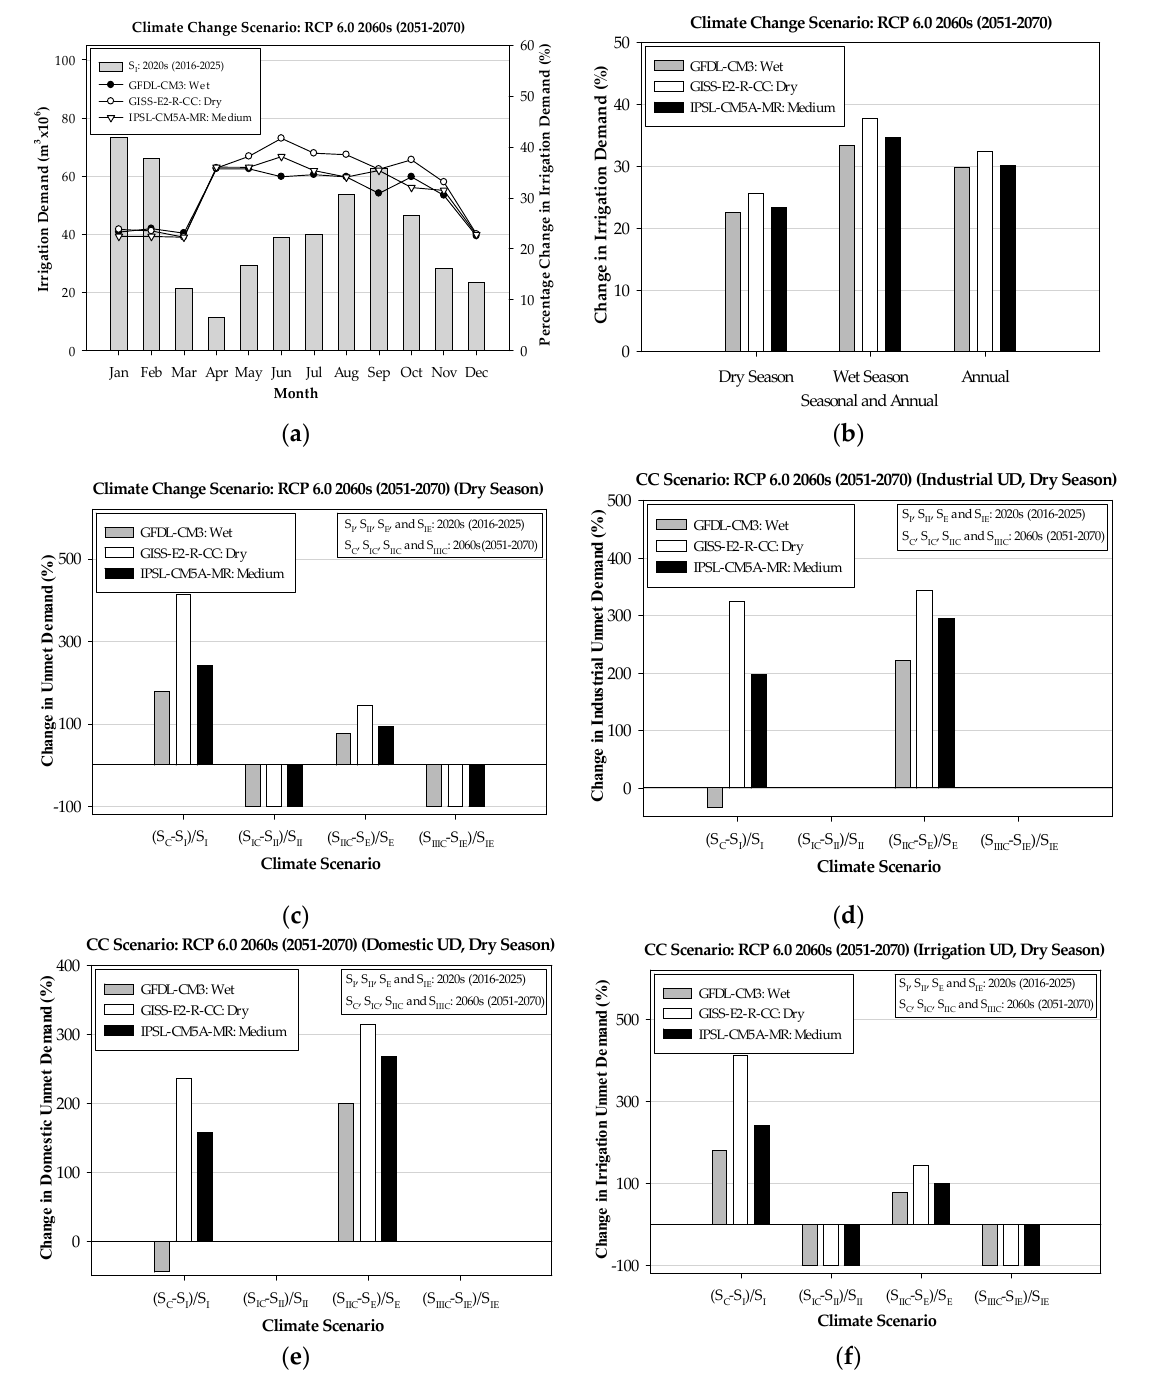
Figure 10. ( a ) The future change in IWD, ( b ) The percentage change in seasonal and annual IWD, ( c ) The percentage change in future unmet demand, ( d ) The percentage change in future IDUn, ( e ) The percentage change in future DWUn, ( f ) The percentage change in future IWUn.